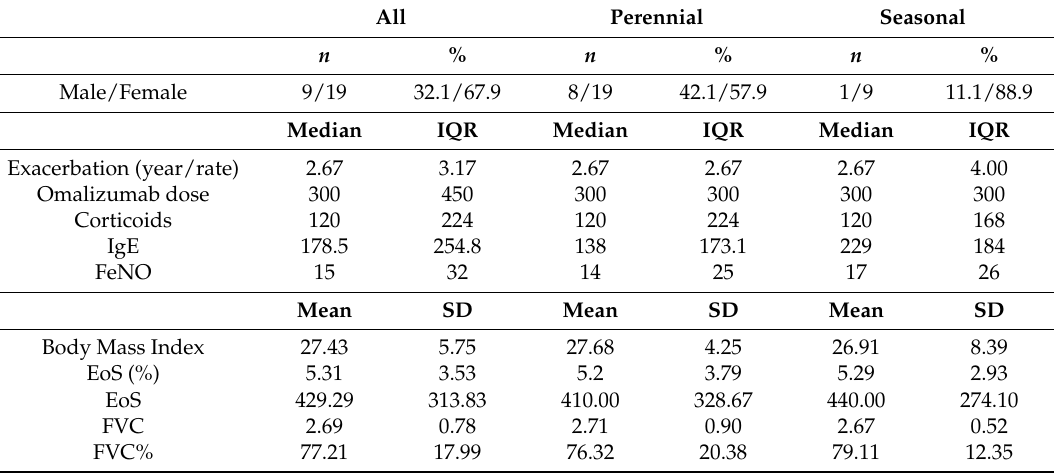
Table 1. Demographic data at entry of the whole group and the two